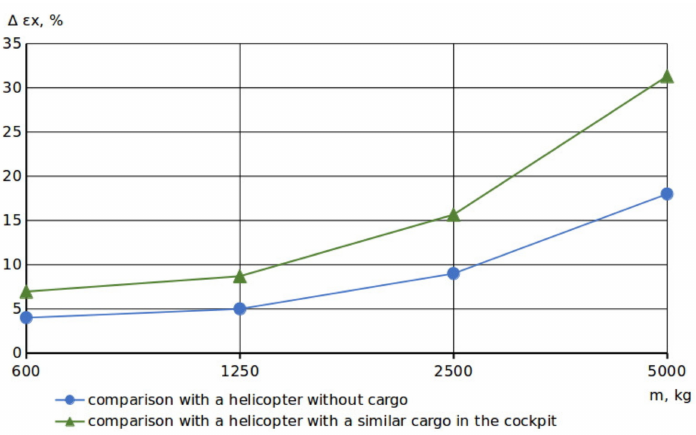
Figure 3. Influence of cargo mass on roll angular